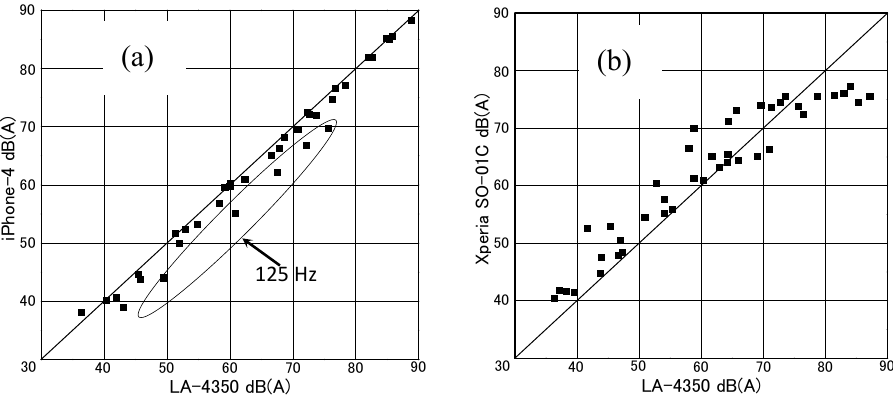
Figure 1. Examples of accuracy of sound level measuring application (SPL Meter) for ( a ) iOS device (iOS 5.0) and ( b ) Android device (Android OS 4.2) [12].